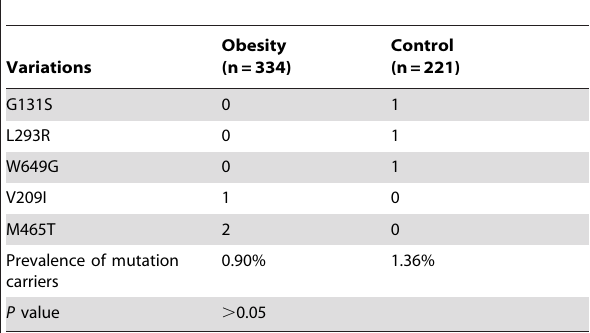
Table 4. Prevalence of SH2B1 rare non-synonymous mutations in obese and lean children.